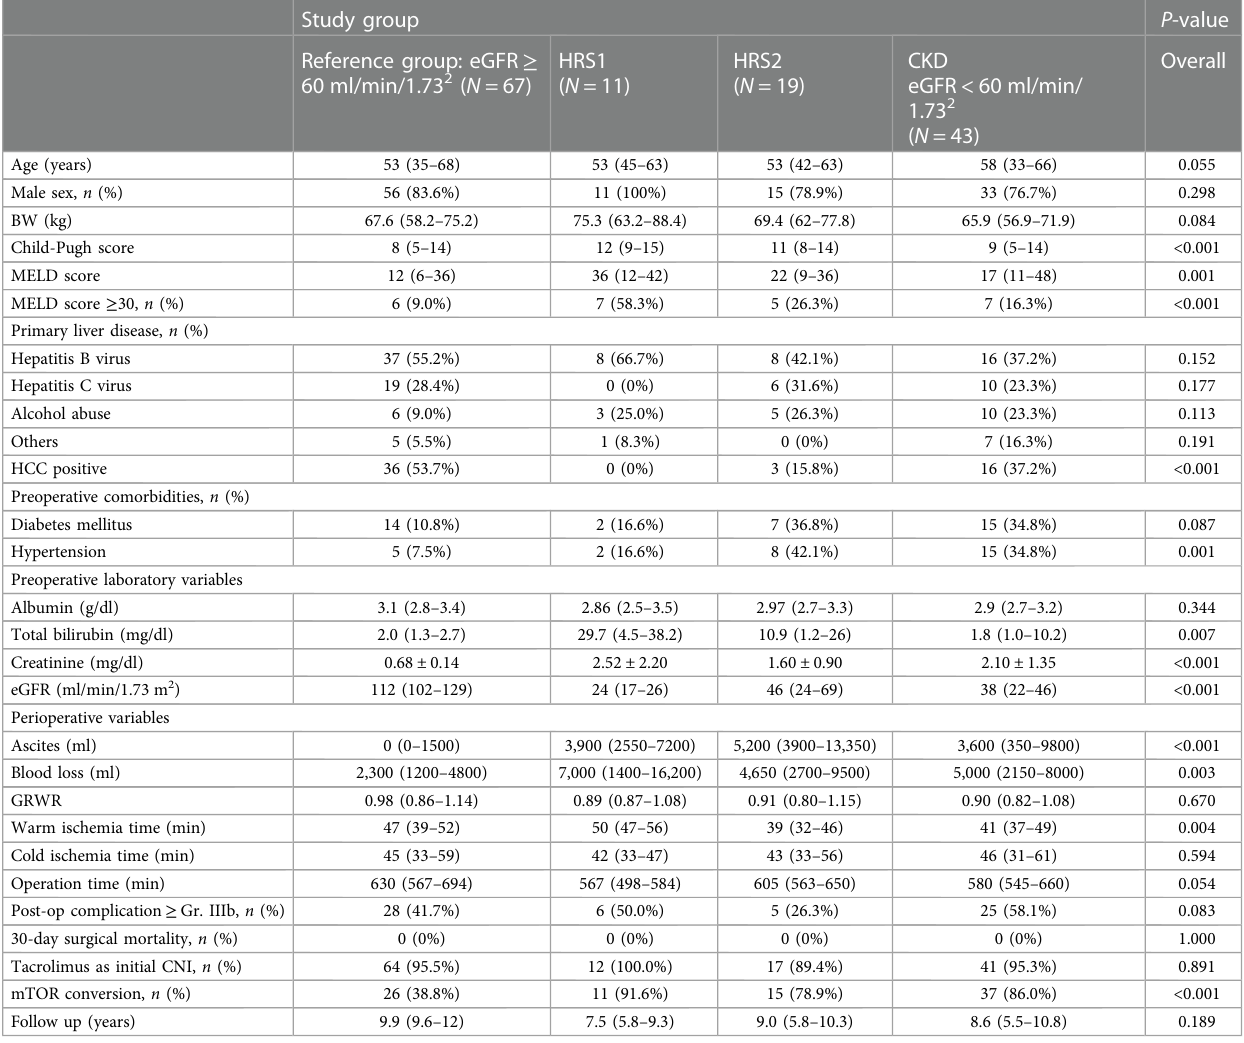
TABLE 2 Characteristics of the patients undergoing LDLT sub-grouped by preoperative renal